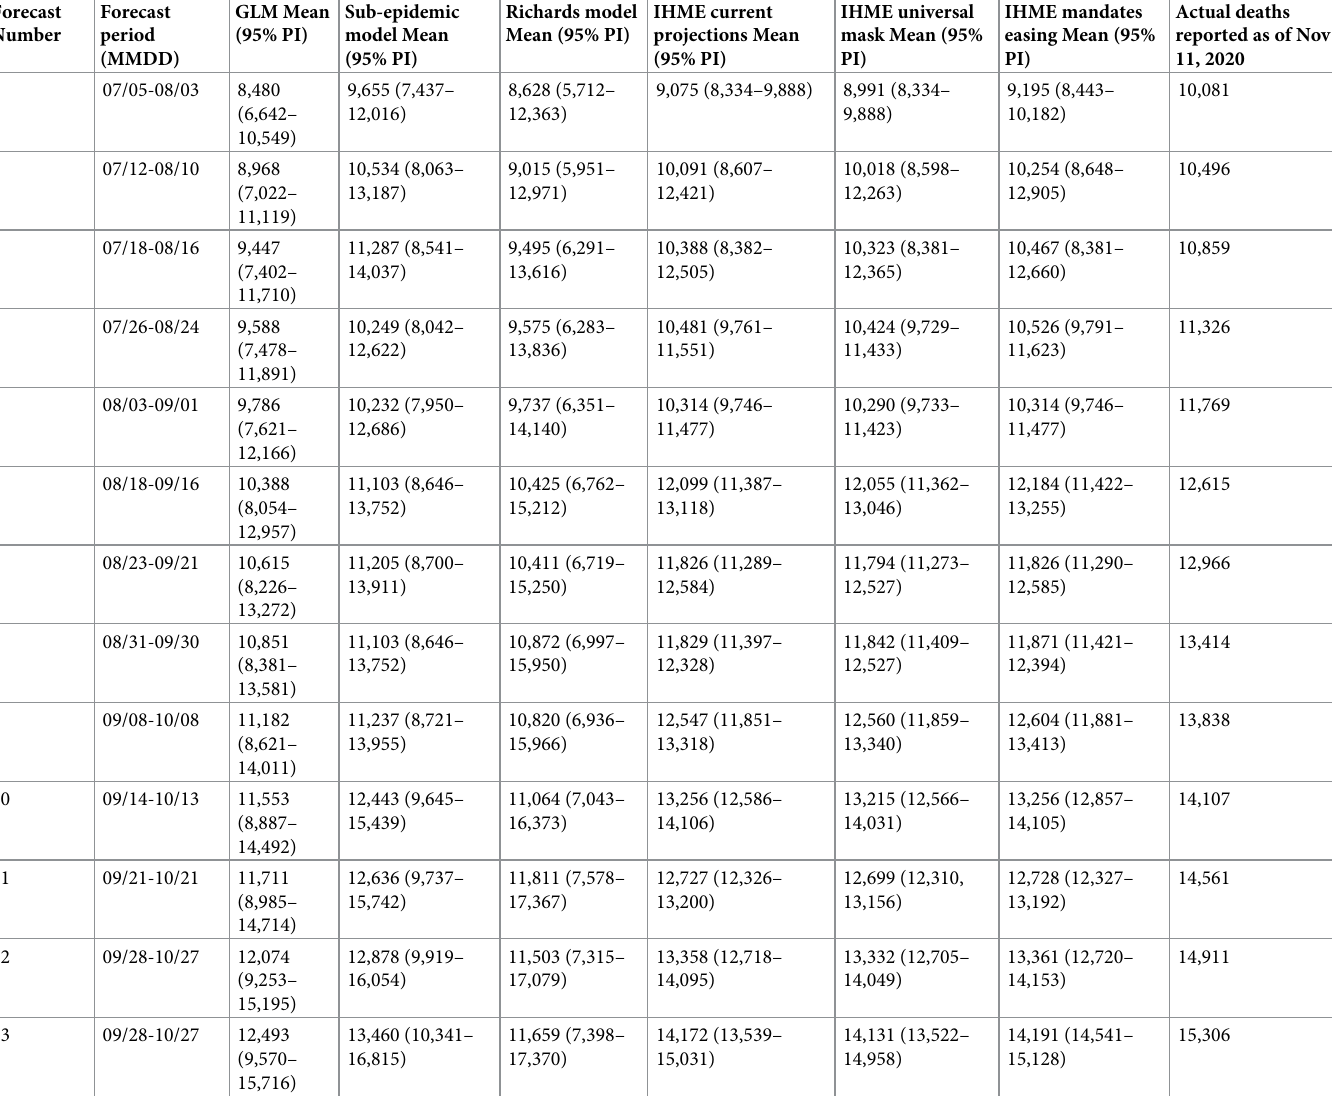
Table 3. Cumulative mortality estimates obtained from the six models (GLM, Richards model, sub-epidemic model, IHME current projections, IHME universal mask, and IHME mandates easing) at the end of each forecasting period for the COVID-19 pandemic in Mexico City